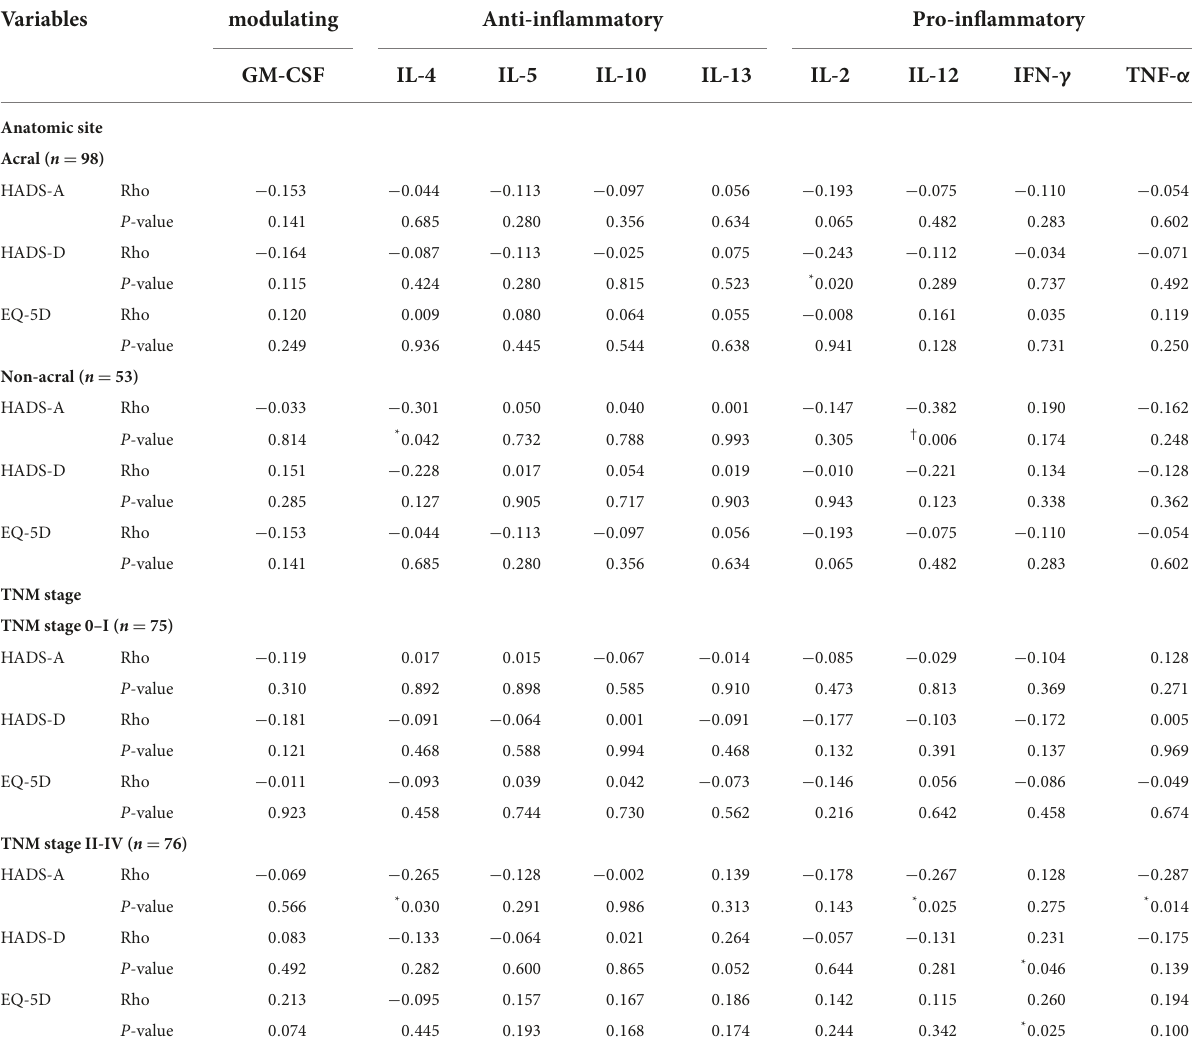
TABLE 2 Correlations of cytokine levels with anxiety, depression, and QOL by melanoma site and TNM